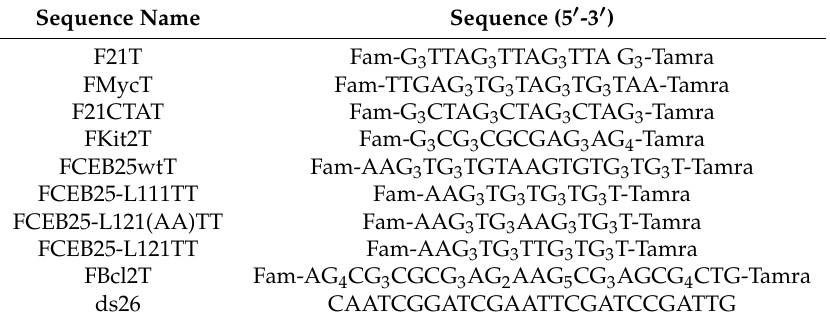
Table 4. DNA sequences employed for the FRET melting